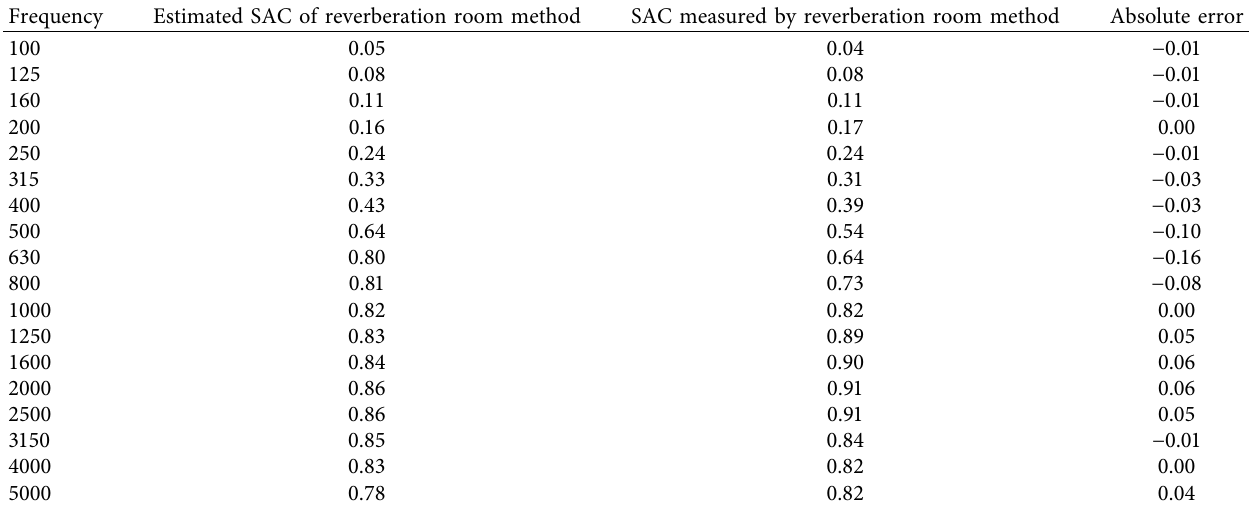
Table 6: Absolute error of the 64K25 estimation